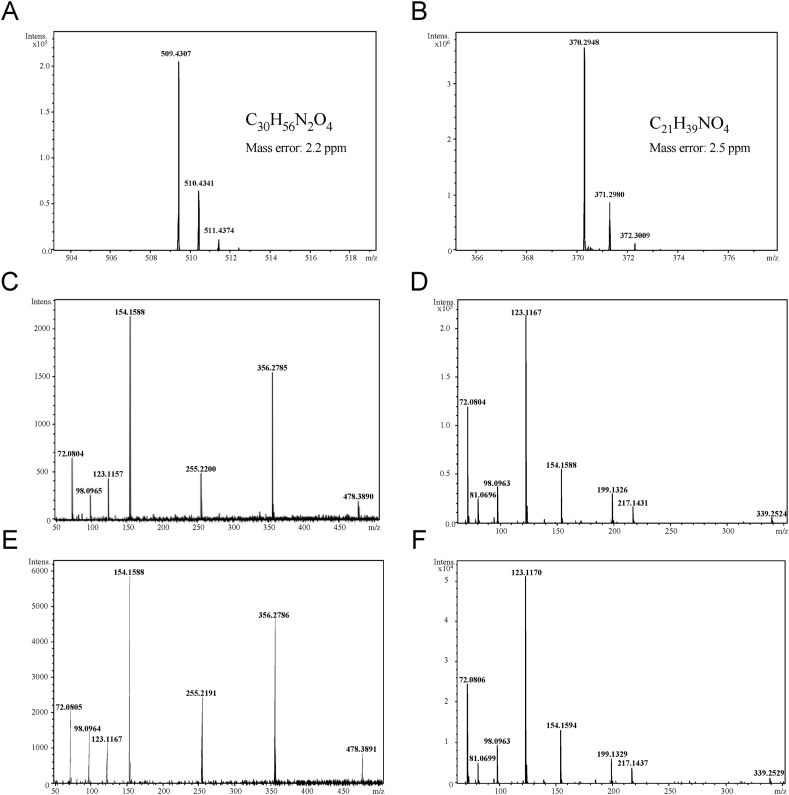
Mass-spec analysis of DLT leachate and identification of Tinuvin 292 mixture. Zoom-in raw MS spectra for dominant peaks identified with elution times of (A) 4.8–5.0 min and (B) 0.9–1.0 min from the DLT leachate. Tandem mass spectroscopy (MS/MS) was performed to create fragmentation spectra for the (C) 370 and (D) 509 ions. MS/MS of similar ions identified in Tinuvin 292 result in similar MS/MS spectra for the (E) methyl 1,2,2,6,6-pentamethyl-4-piperidyl sebacate and (F) bis(1,2,2,6,6-pentamethyl-4-piperidyl) sebacate components of the mixture. For display purposes, the parent mass was ignored in spectra creation and the acquisition low mass cutoff was used for the low mass limit and the highest fragment mass created via MS/MS was used for the high mass limit displayed in spectra to show detail of the relevant product masses.